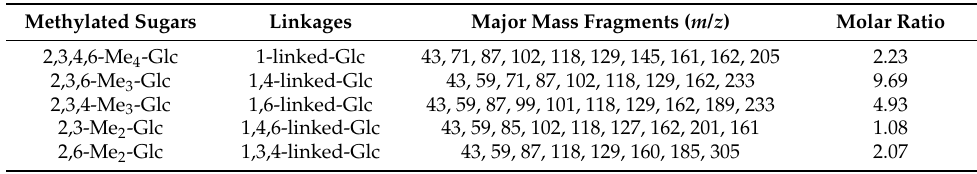
Table 1. Linkage patterns analysis of GEP-1.